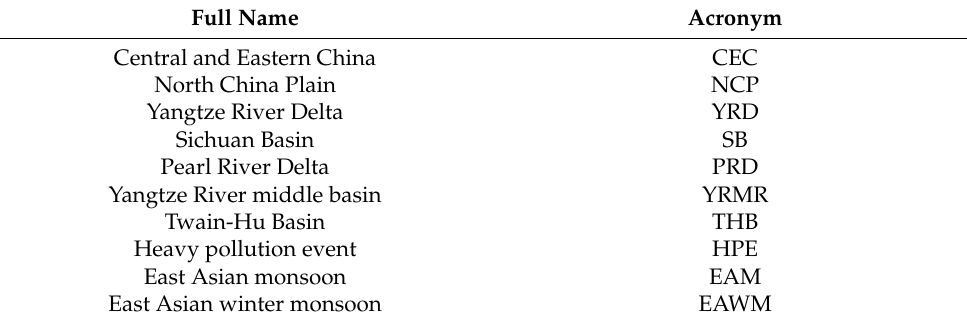
Table 1. Summaries of the full names and acronyms used in this study .